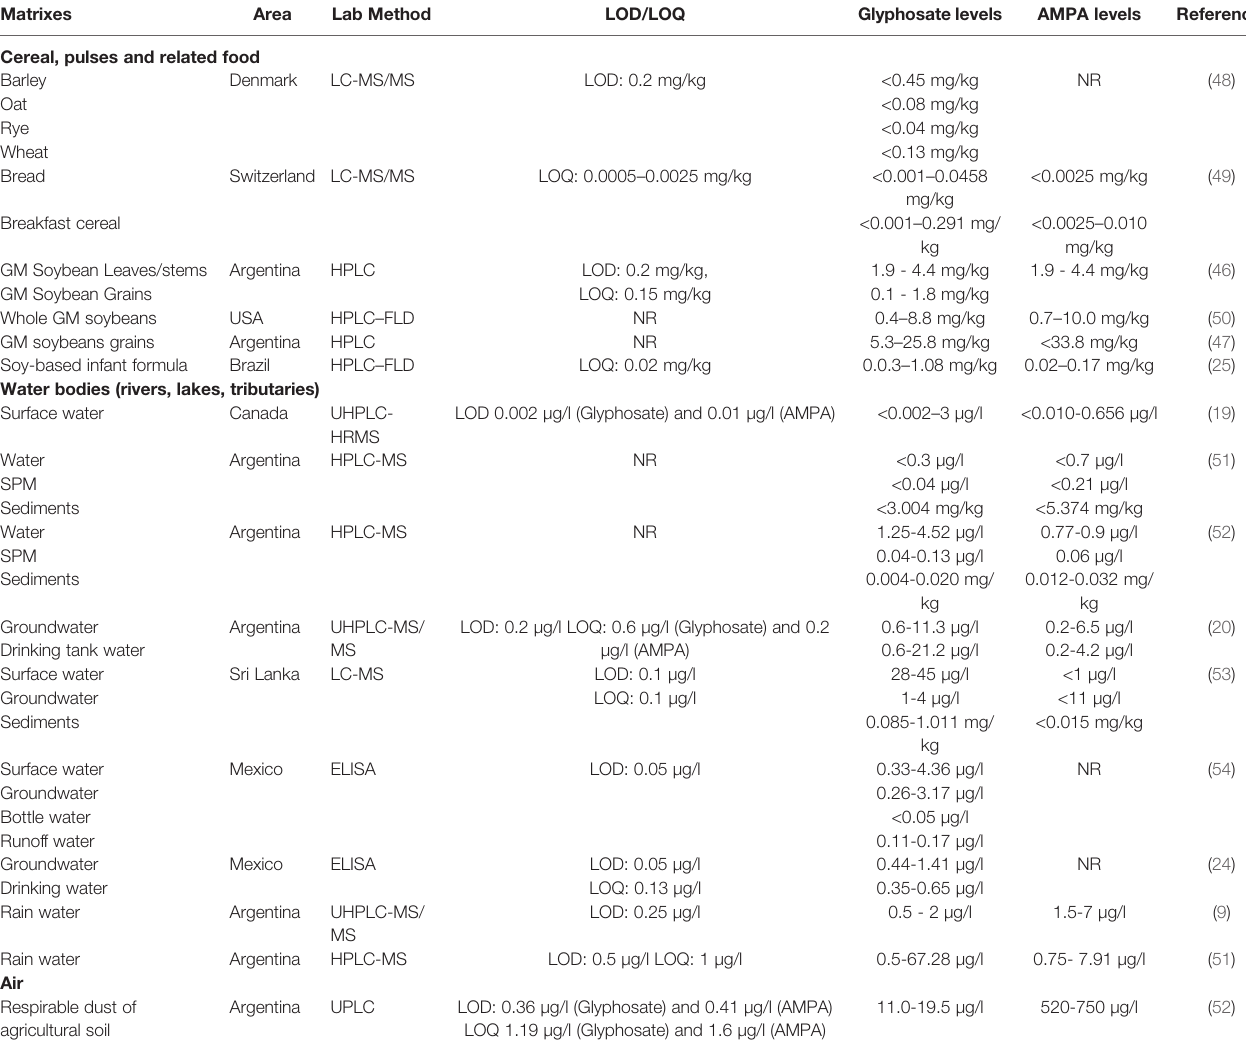
ELISA, enzyme-linked immunosorbent assay; FLD, fl uorescence detector; HPLC, High Performance Liquid Chromatography; HRMS, high resolution mass spectrometry; LC, liquid chromatography; LOD, limit of determination; LOQ, limit of quanti fi cation; MS/MS, tandem mass spectrometry; MS, mass spectrometry; NR, not reported; SPM, suspended particulate matter; UHPLC, Ultra High Performance Liquid Chromatography; UPLC, Ultra Performance Liquid